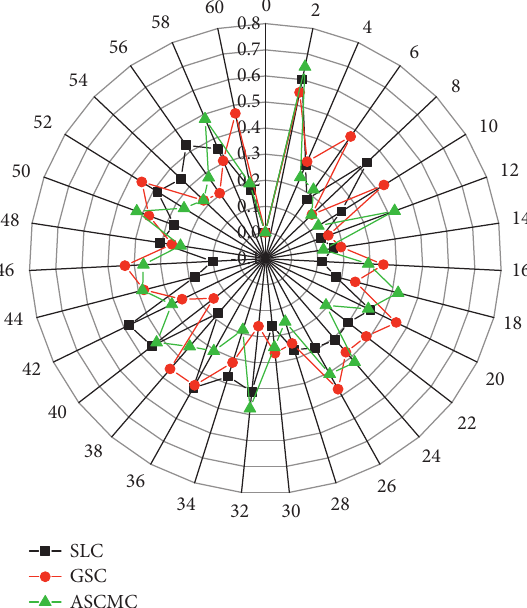
Figure 7: Comparison of the cost of controller disconnectivity.